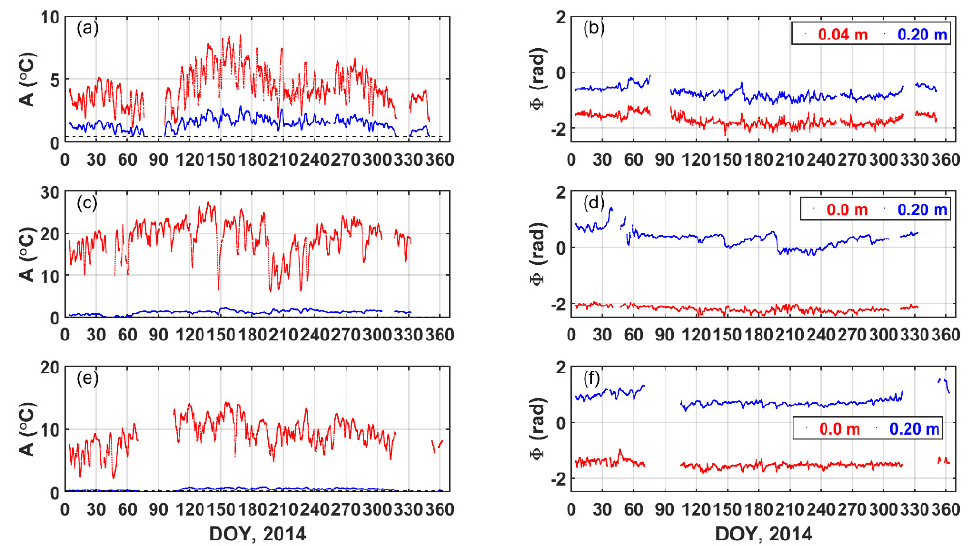
Figure 3. The variations of hourly soil temperature amplitude (A, °C) and phase ( Φ , rad) at two depths of 0.04 m (or 0.0 m) and 0.2 m at ( a , b ) BJ, ( c , d ) QOMS, and ( e , f ) NADORS for 2014.